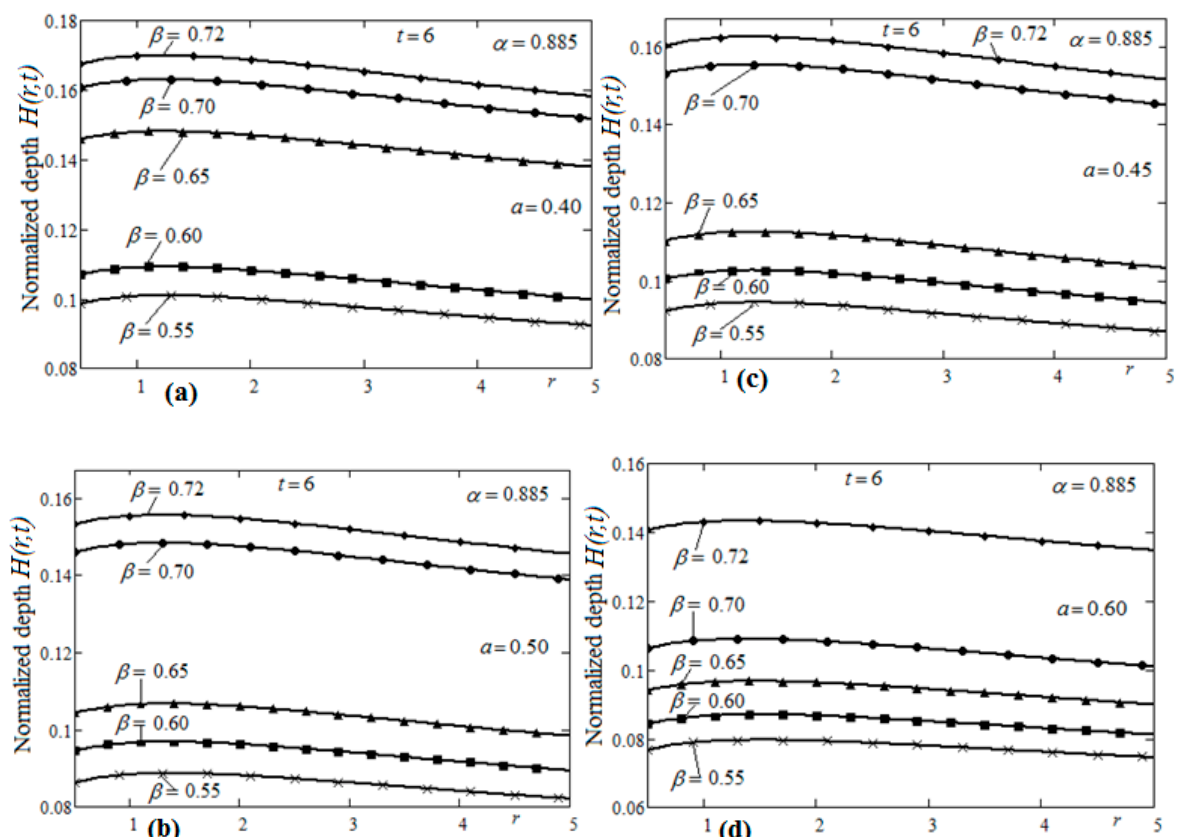
∈ , figures ( a , b ), respectively Figure 3. The profiles of the normalized depth H ( r , t ) for a ∈ { 0.4,0.5 } , figures ( a , b ), respectively a ∈ { 0.45,0.6 } ,